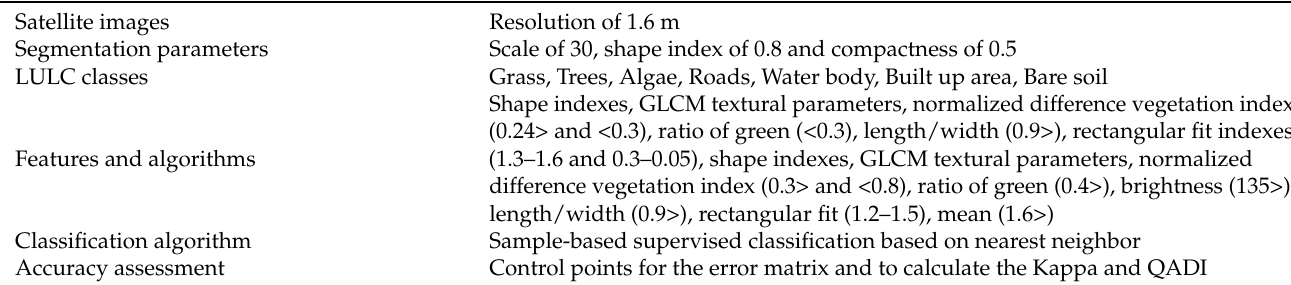
Figure 4. Toolbox developed for the implementation of QADI. Table 4. Details of the OBIA-based LULC classification for the Sydney use case.